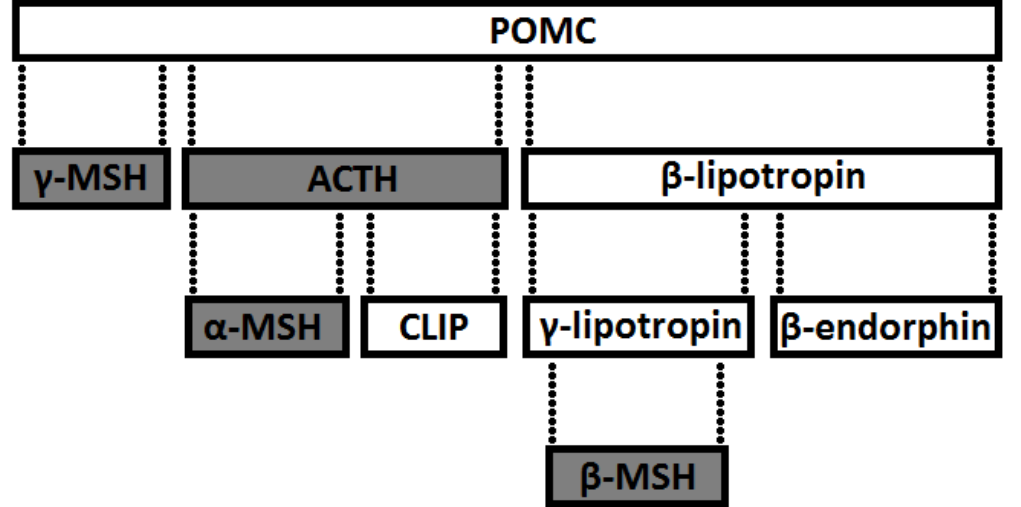
Figure 4. Scheme depicting the structure of biologically active fragments of prohormones as precursors of opioid pep- Signal peptides are marked as shaded spaces (modified according to tides. Signal peptides are marked as shaded spaces (modified according to [29]).